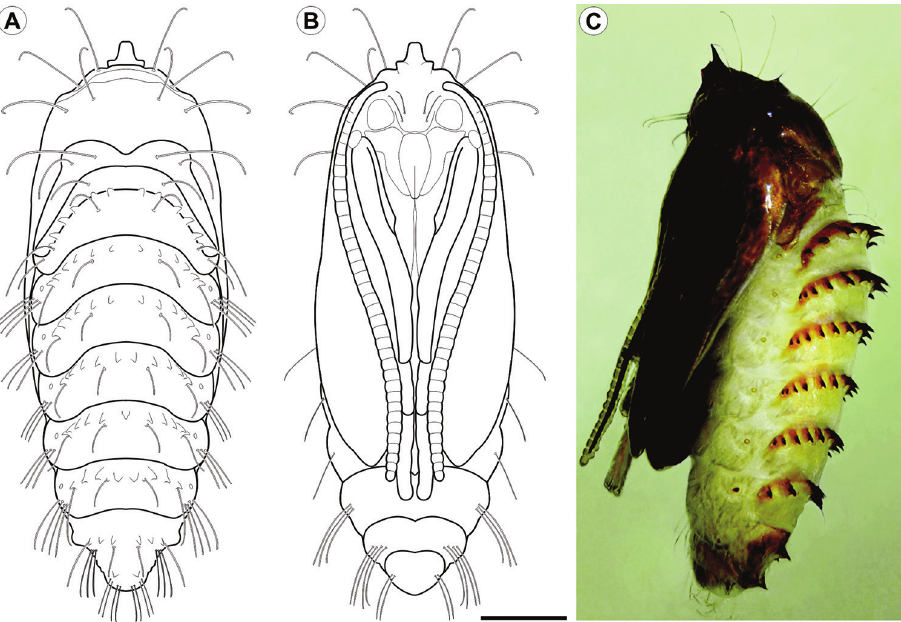
Figure 7. Cecidonius pampeanus pupa with light microscopy, under dorsal ( A ), ventral ( B ) and lateral ( C ) views. Scale bar: 1